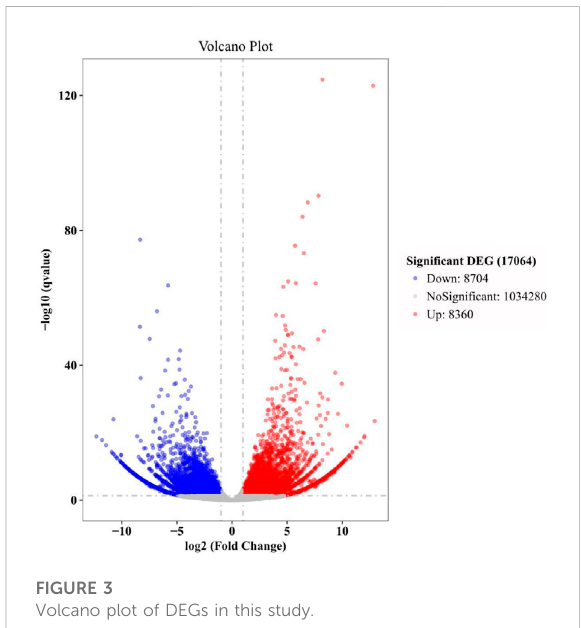
FIGURE 3 Volcano plot of DEGs in this